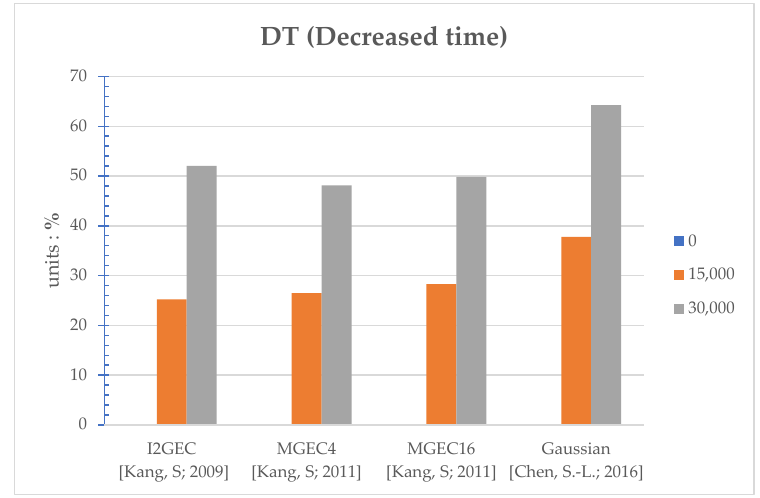
Figure 3. Bar comparisons of the DT (decreased time, %) of different algorithms at different thresholds [9,10,13].